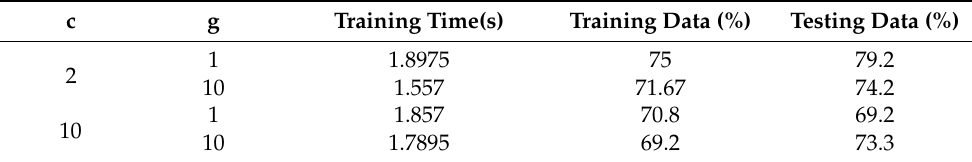
Table 4. Correction rate by SVM multi-classifier with WPA